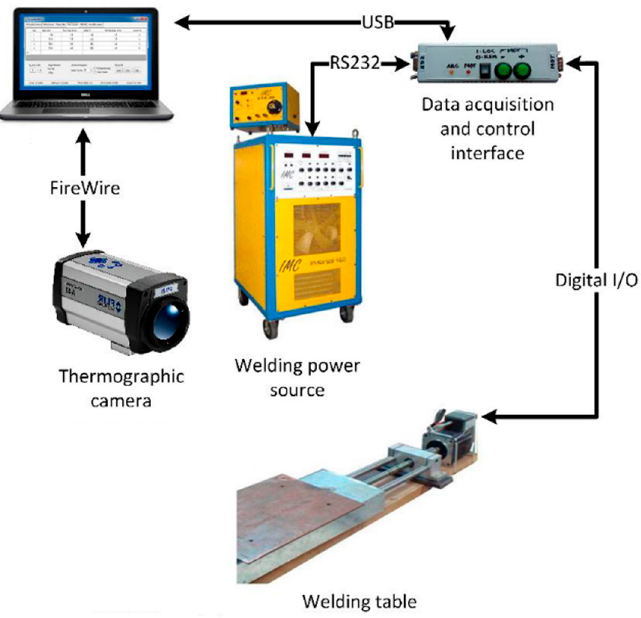
Figure 2. Schematic overview of components and connections of data acquisition and open-loop control system. Adapted from [13].